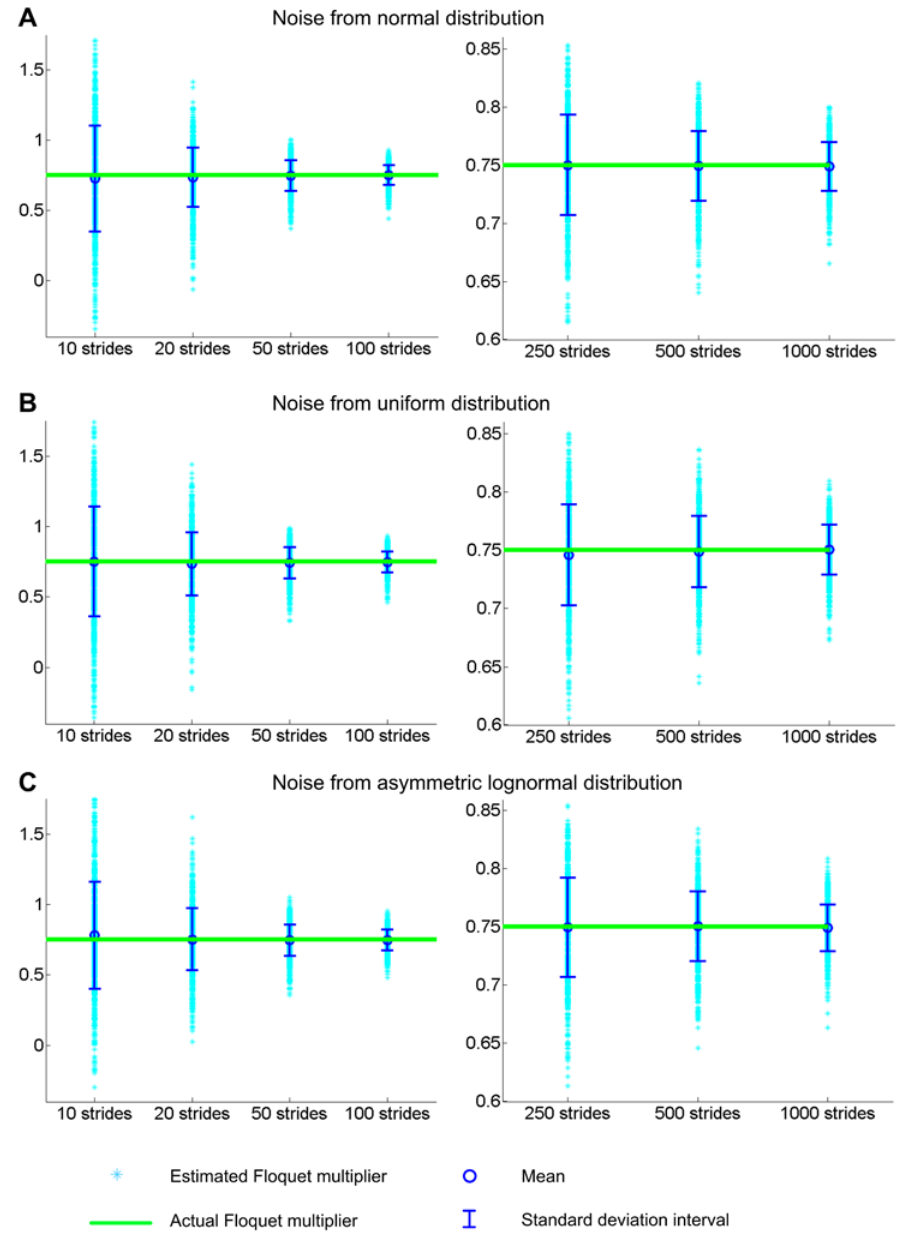
Fig 3. Estimation of a Floquet multiplier (FM) using a new method that estimates the bias of previous methods. An adjustment calculated based on Burg ’ s method was added to a first estimate based on the Yule-Walker equation. Time series with different length, n were generated with FM = 0.75 and various distributions of noise: normal (A), uniform (B) and asymmetric lognormal (C). The FM was evaluated for each time series using this new method. The simulation was repeated 1000 times for each n . Compared with the previous methods, the bias is substantially reduced. With this method, H 0 — the null hypothesis that the estimated orbital stability comes from a distribution with mean equal to the actual value — is accepted when n (cid:5) 50 for normally or uniformly distributed noise (A and B), and n (cid:5) 20 for asymmetrically distributed noise (C).